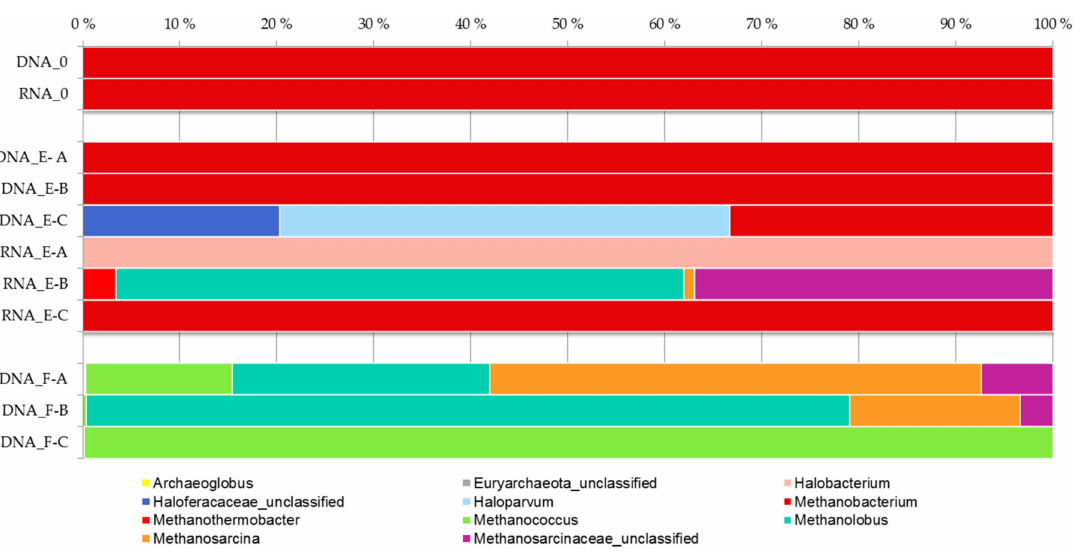
Figure 2. PCoA plot on bacterial samples. Samples DNA_0 and RNA_0 are the samples representing original fracture fluids. Samples DNA_E and RNA_E are enriched microcosm samples and DNA_F represent acetate assimilating labelled fractions. Axis 1 and 2 explains 17.7% and 16.3% of the variance, respectively.